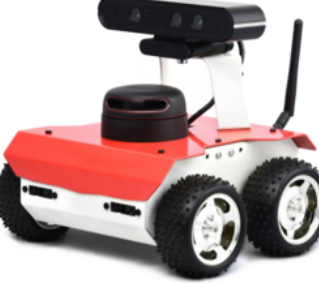
Figure 6. Husarion Rosbot 2.0.